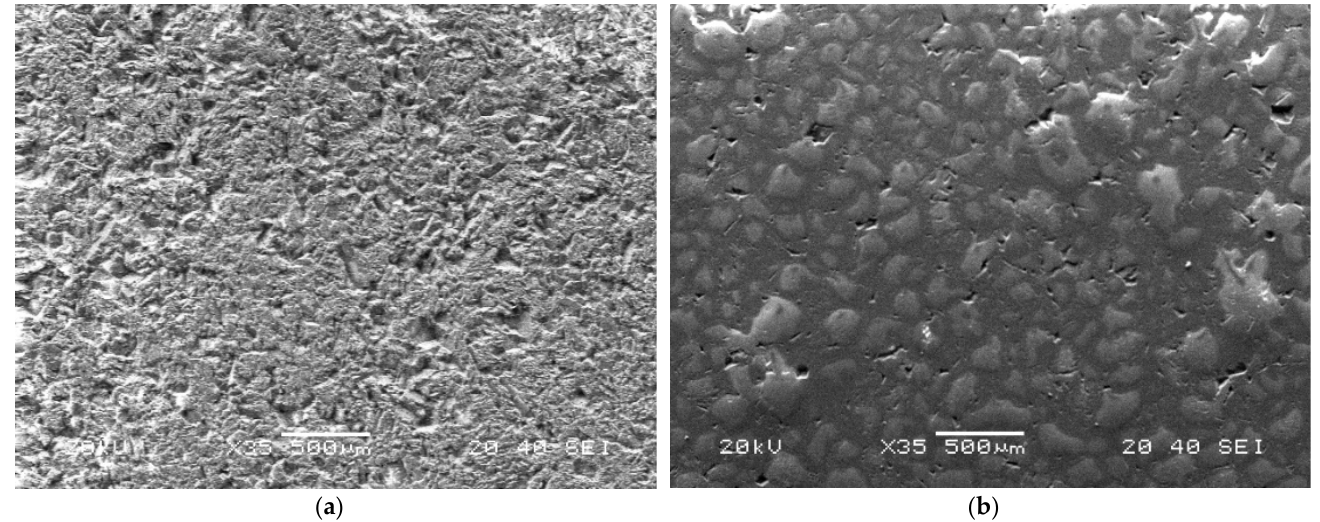
Figure 1. ( a ) Thin section of unpolished surface; ( b ) thin section of polished surface.